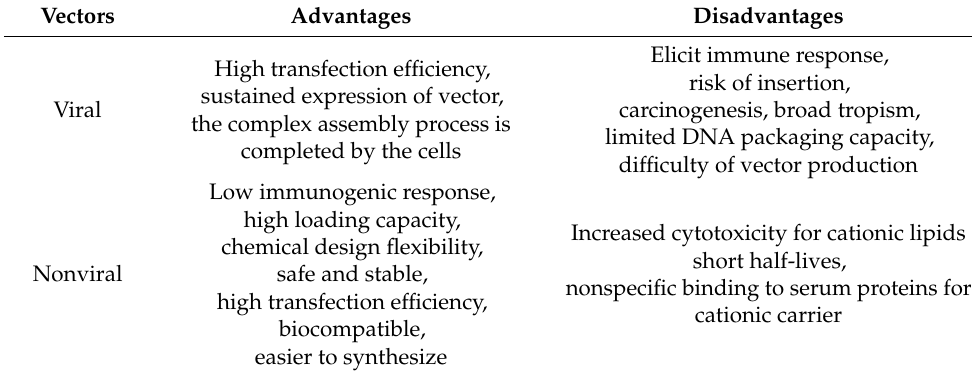
Table 1. Advantages and disadvantages of viral and nonviral vectors.